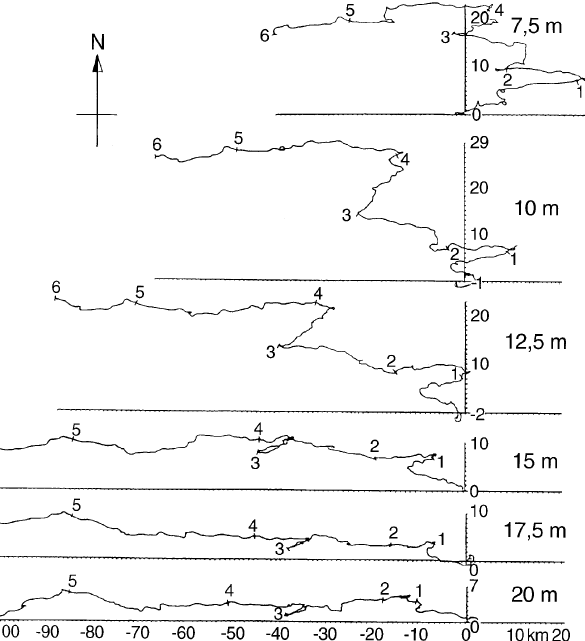
Fig. 11. For station VI (see Fig. 10 for station location). Progressive vector diagrams of six depths recorded simultaneously during the mooring period in September 1988. Data sampling interval was 5 min. Negative directions are westward. „ ick marks on the curves were drawn every five days and are labeled in consecutive